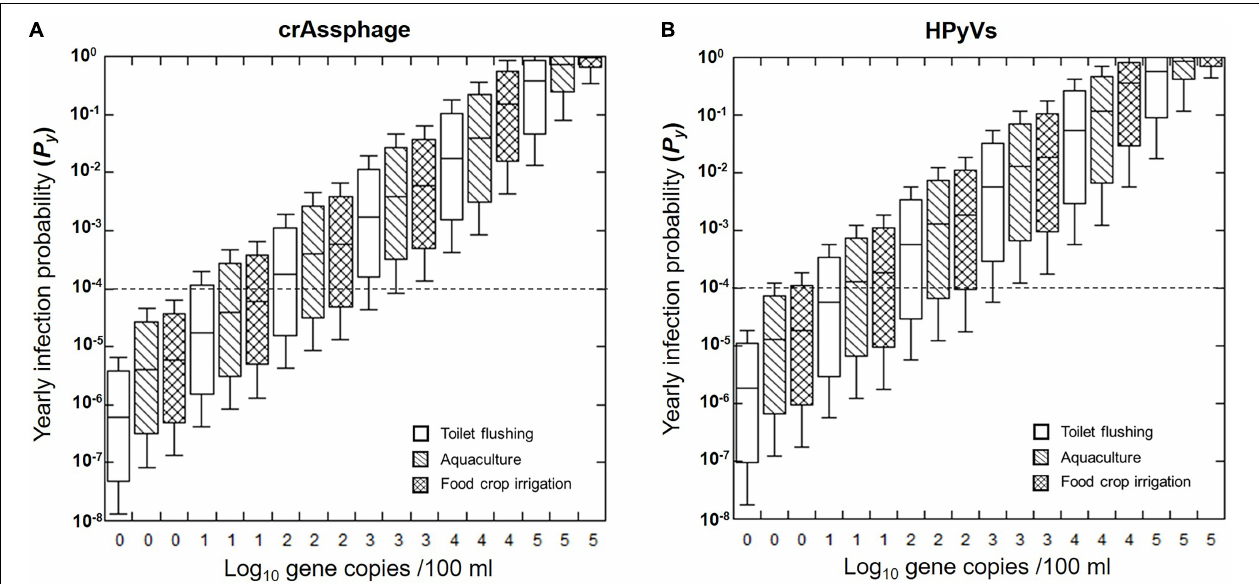
FIGURE 4 | Predicted annual probability of infection ( Py ) for HAdV40/41 based on crAssphage (A) and HPyVs (B) . Box plots represent the estimated 25th to 75th percentiles, with the median between. The whiskers exhibit the 5th and 95th percentile values. The dashed lines indicate the US EPA annual risk benchmark of 10 − 4